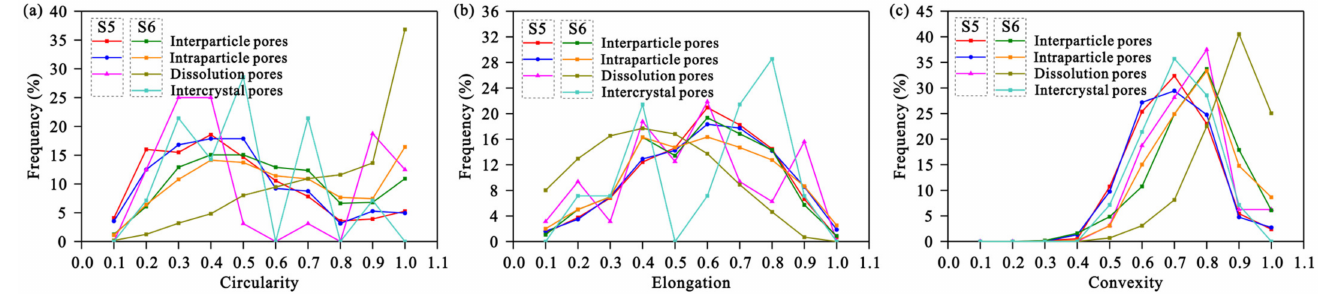
Figure 9. Pore morphology parameters in felsic shales: ( a ) Circularity; ( b ) Elongation; ( c ) Convexity.